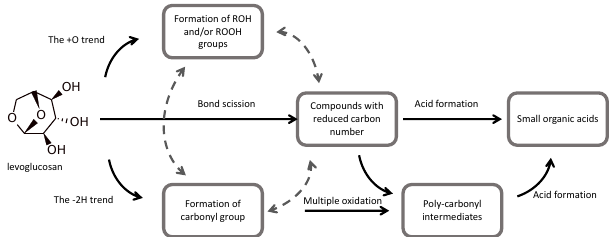
Figure 8. A simplified overview of reaction mechanisms discussed in the current study. Solid arrows represent proposed reaction path- ways of LG upon OH oxidation. The dashed arrows illustrate the complicity in the reaction system where each product can also take more than one reaction path.